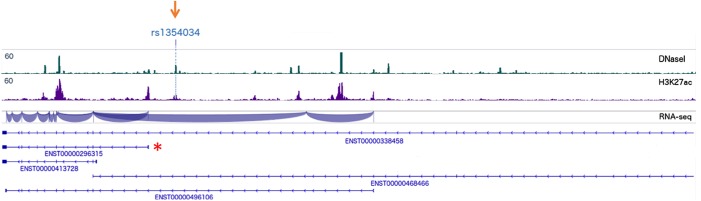
rs1354034 is located in a DNase I hypersensitive region in primary human MKs.Shown is the chromatin locus containing the ARHGEF3 gene. rs1354034 (orange arrow) is located in an open-chromatin (DNase I peak) non-coding region upstream of the transcription start site of ENST00000296315 (the most commonly transcribed mRNA in MK, indicated by an asterisk). Green: DNase 1 peaks, Purple: H3K27Ac ChIP peaks, Blue: intron/exon boundaries, Bottom: major ENST’s identified for ARHGEF3.